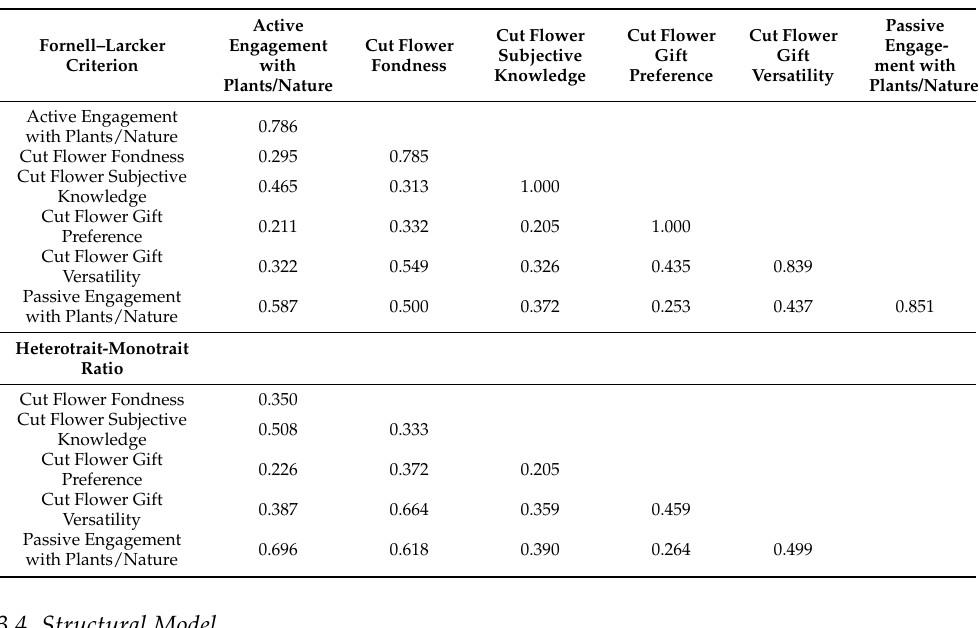
Table 3. Fornell–Larcker Criterion and Heterotrait Multitrait